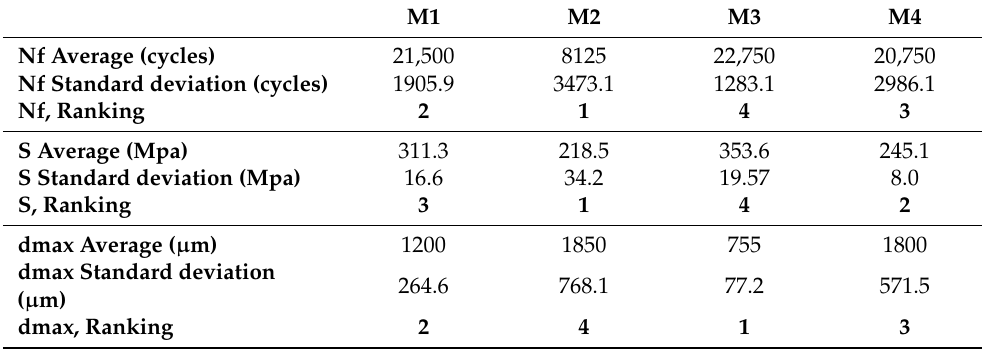
Figure 10. Relationship between maximum deflection, stiffness and fatigue life of the different mortars studied. Table 6. Average values obtained at a load level of 10 N employed in the construction of the parametric